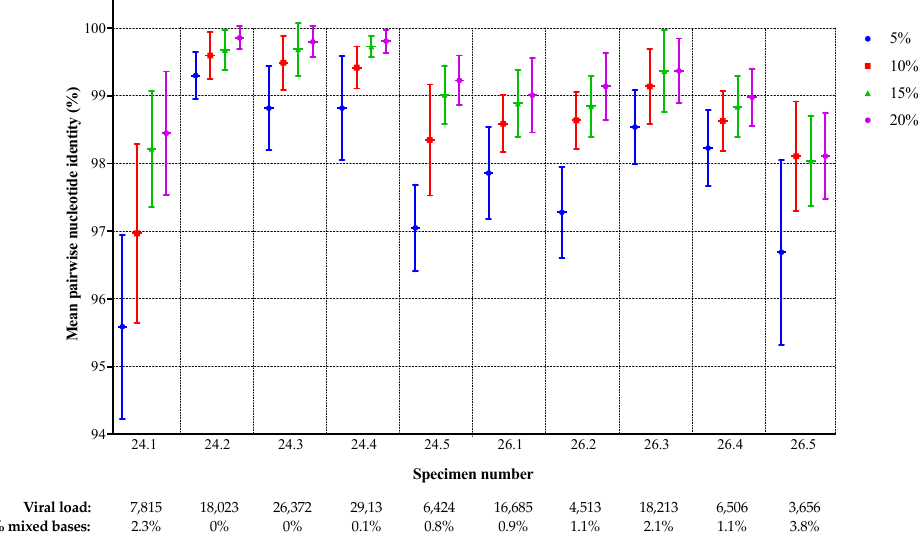
Figure 3. Protease / reverse transcriptase nucleotide sequence concordance between laboratories. The mean percent identity with standard deviation is shown for each specimen and threshold.